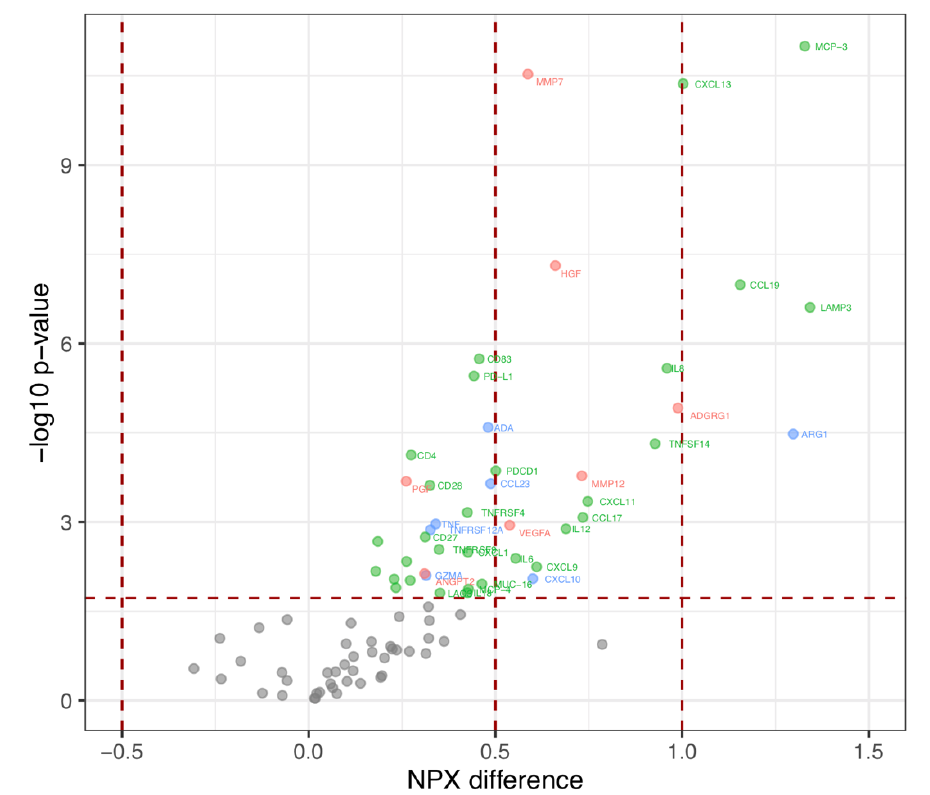
Figure 2. Levels of circulating proteins in IPF patients versus controls. Volcano plot of the difference in relative protein amount (NPX) (x-axis) by log10 of p -value. Red: proteins associated with tissue remodeling; Green: proteins associated with inflammation/chemotaxis; Blue: proteins with overlapping functions. One-way ANOVA adjusted for age with Benjamini–Hochberg corrected p -value to control a false discovery rate at 5%.